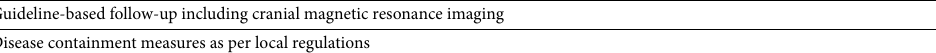
Table 7. Best practice recommendations for the treatment of patients with high-grade gliomas during a